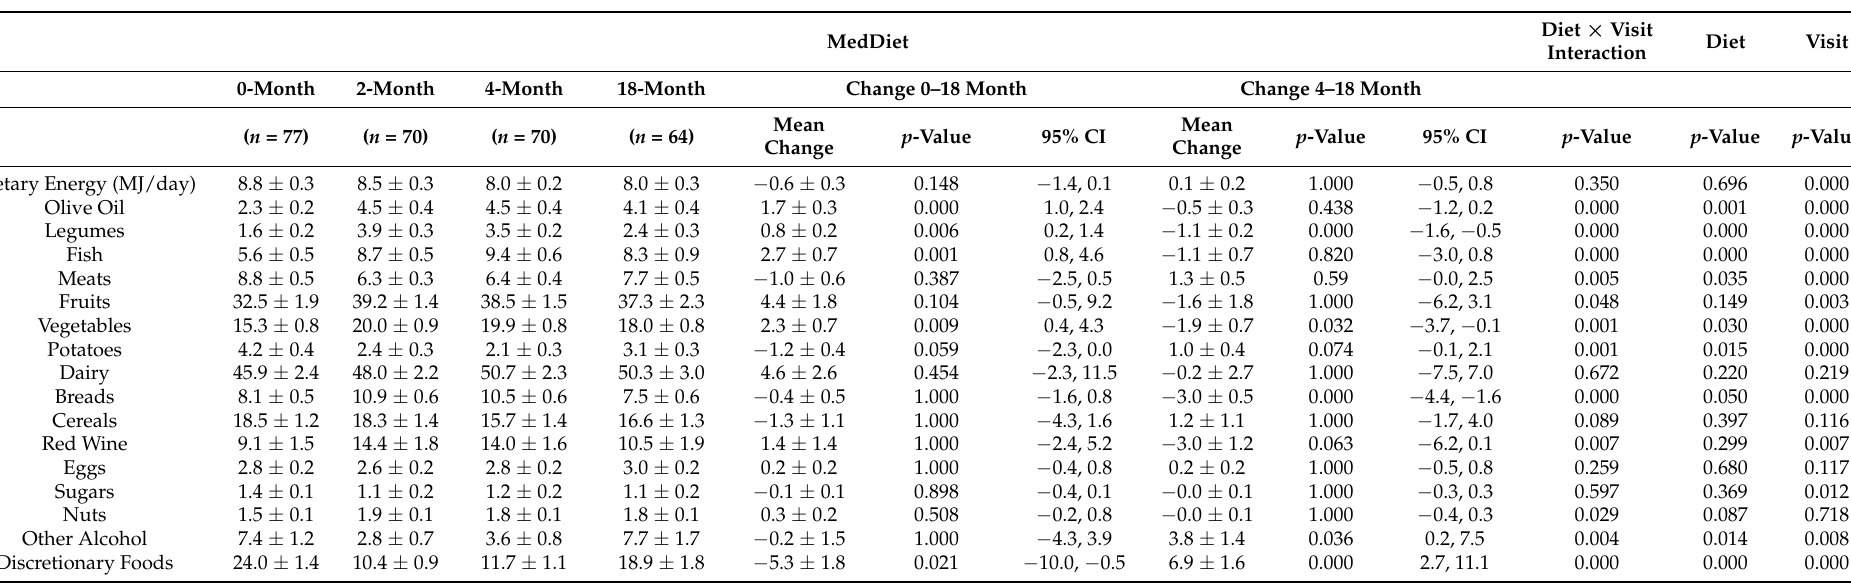
Table 4. Dietary Intake of grouped foods (g/MJ/day) at baseline (0 months) and during 6 months dietary (measured at 2 and 4 months) intervention and 12 months after intervention ceased (18